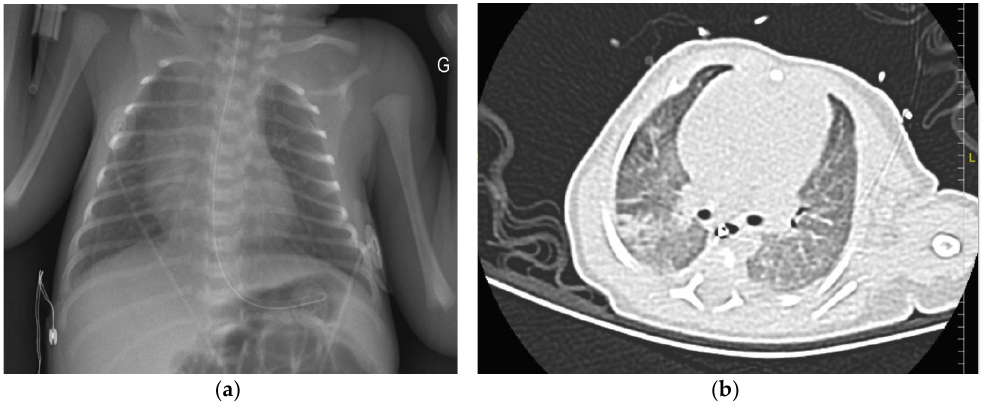
Figure 1. ( a ): Chest X-ray of a neonatal infant with transient respiratory distress on admission; ( b ): chest CT scan at day 14 of life, showing consolidation and ground glass opacities.